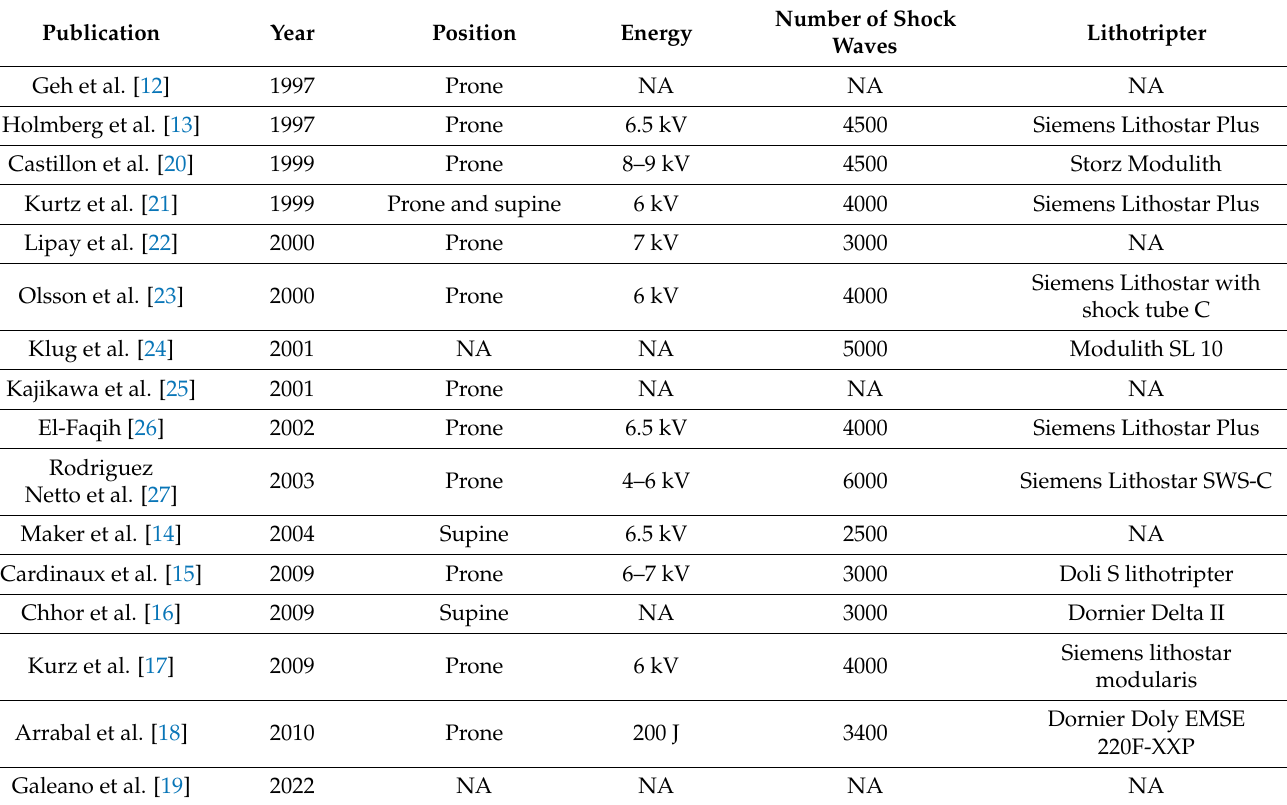
Table 2. Characteristics of